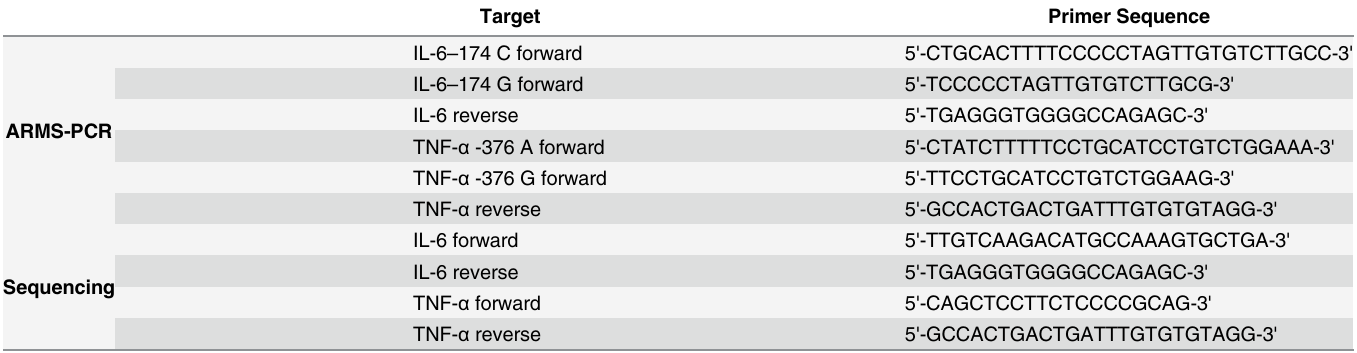
Table 1. Primers for ARMS-PCR and sequencing analysis of IL-6 and TNF- α